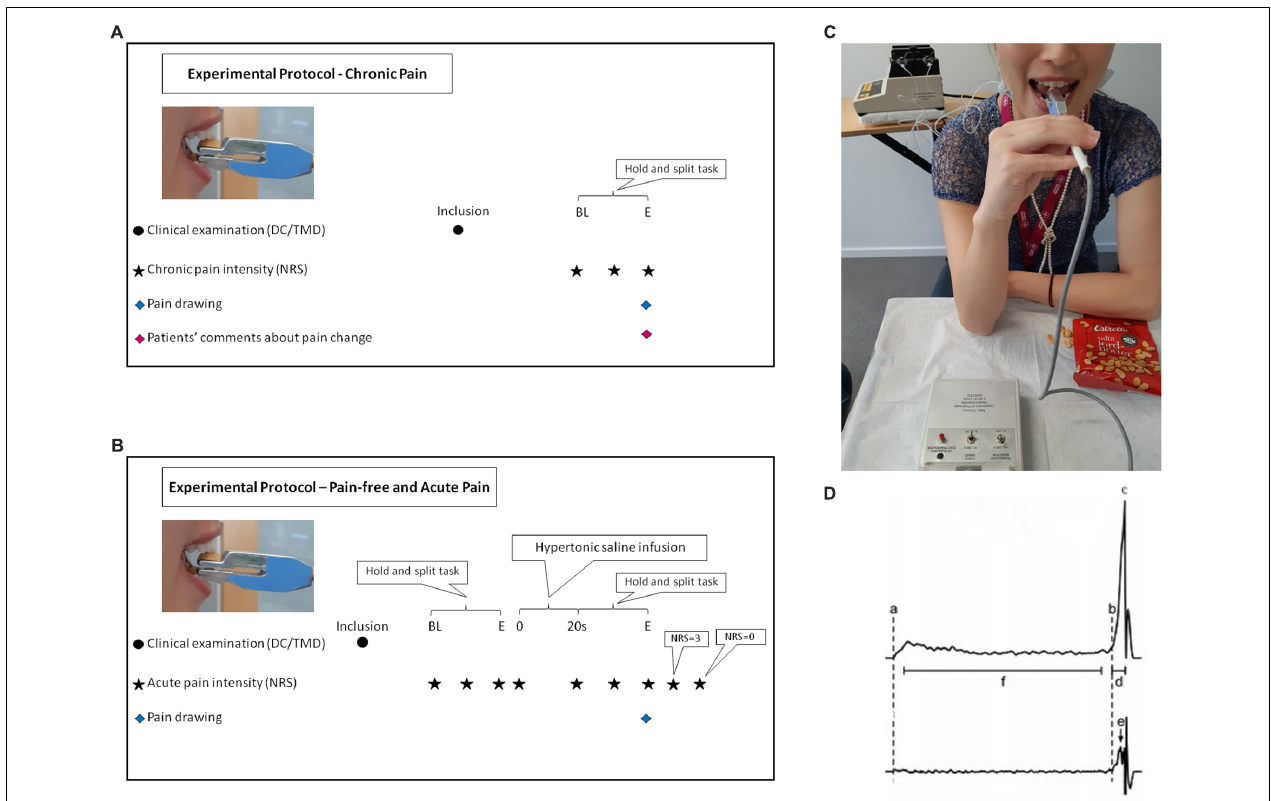
FIGURE 1 | Flow-chart illustrates the experimental protocol for chronic pain (A) . BL, baseline before the task; BL, start of the task; E, end of the task. Flow-chart illustrates the experimental protocol for pain-free and experimental acute pain (B) . BL, baseline before the task; s, second; E, end of the task. DC/TMD, Diagnostic criteria for temporomandibular disorders; NRS, numeric rating scale. Participant performing the hold and split task and the equipment used during the experiment (C) . Estrella half peanut was placed on force transducer during acute induced pain in the masseter muscles bilaterally by infusion of hypertonic saline with Harvard infusion pump. A written informed consent was obtained from the participant in the figure for the publication of the image. A representative schematic force profile (upper trace) and force rate profile (lower trace) of one hold and split trial as shown in the WinZoom program (D) . (a) Initial contact with the food, (b) Initiation of splitting, (c) the split force and end of the split phase, (d) duration of the split phase, (e) peak rate of split force, and (f) hold phase, interval beginning 0.2 s after initial contact with the food and ending 0.2 s prior to the onset of the split